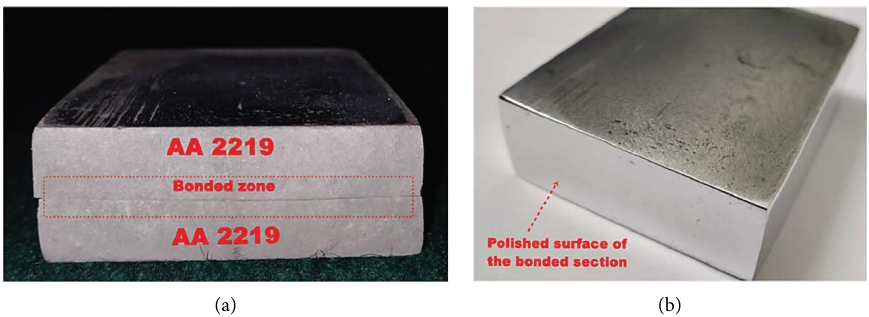
Figure 3: (a) Difusion bonded AA 2219 alloy and (b) polished surface of the bonded